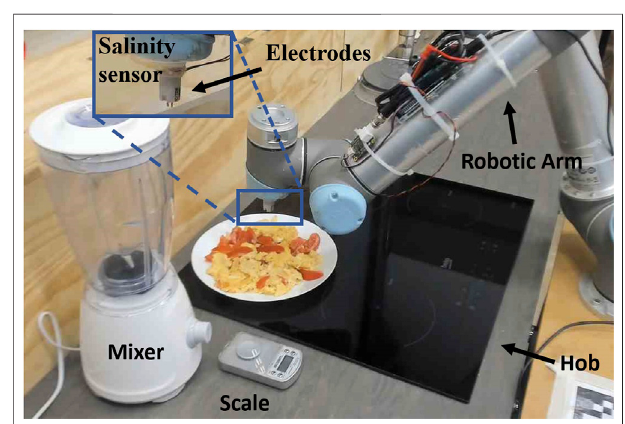
FIGURE 2 | Experimental setup. UR5 robot is fi tted with conductance sensor for saltiness tasting. Induction hob is used for cooking. Food is presented for tasting on a ceramic plate. The whole setup is controlled by a program run on a